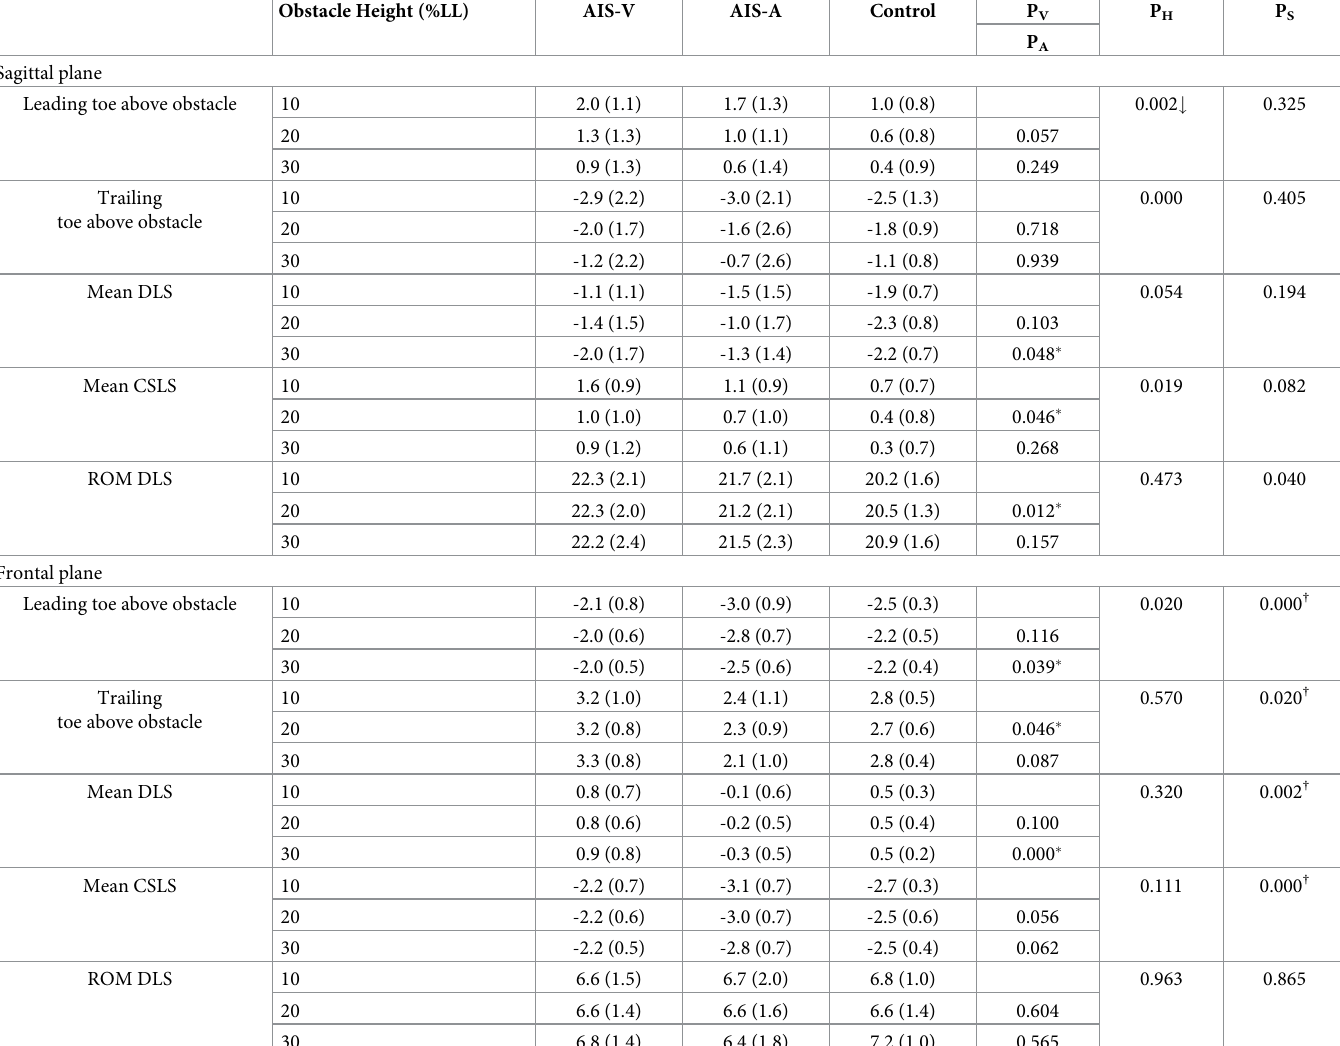
Table 2. Means (standard deviations, SD) of the sagittal and frontal COM-COP inclination angles (˚) in the patients with adolescent idiopathic scoliosis and healthy controls when crossing obstacles of heights of 10%, 20% and 30% of subjects’ leg